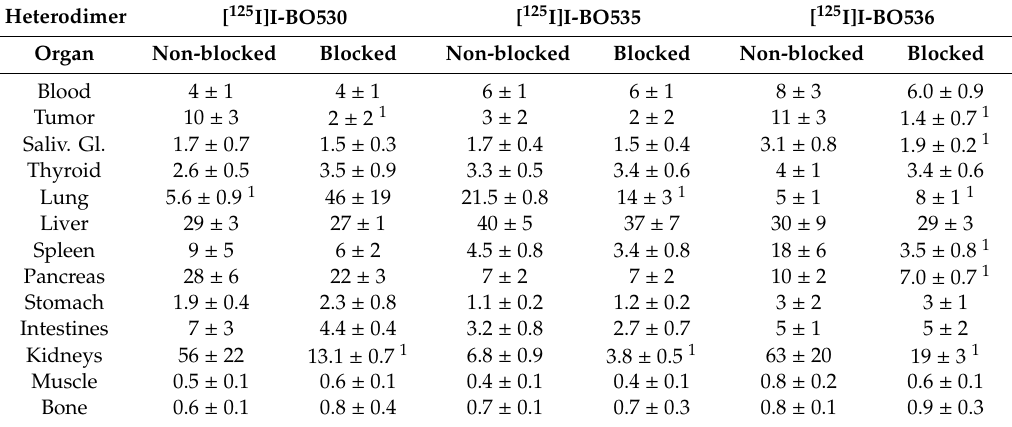
Table 2. In vivo specificity to PSMA tested 1 h pi of [ 125 I]I-BO530, [ 125 I]I-BO535, and [ 125 I]I-BO536 (%ID / g). Balb / c nu / nu mice with LNCaP xenografts were injected with 40 pmol (30 KBq) of labeled heterodimer (non-blocked group). For the specificity test, the heterodimer was co-injected with 7.5 nmol of unlabeled PSMA-617 (blocked group). Data are presented as mean value ± standard deviation.